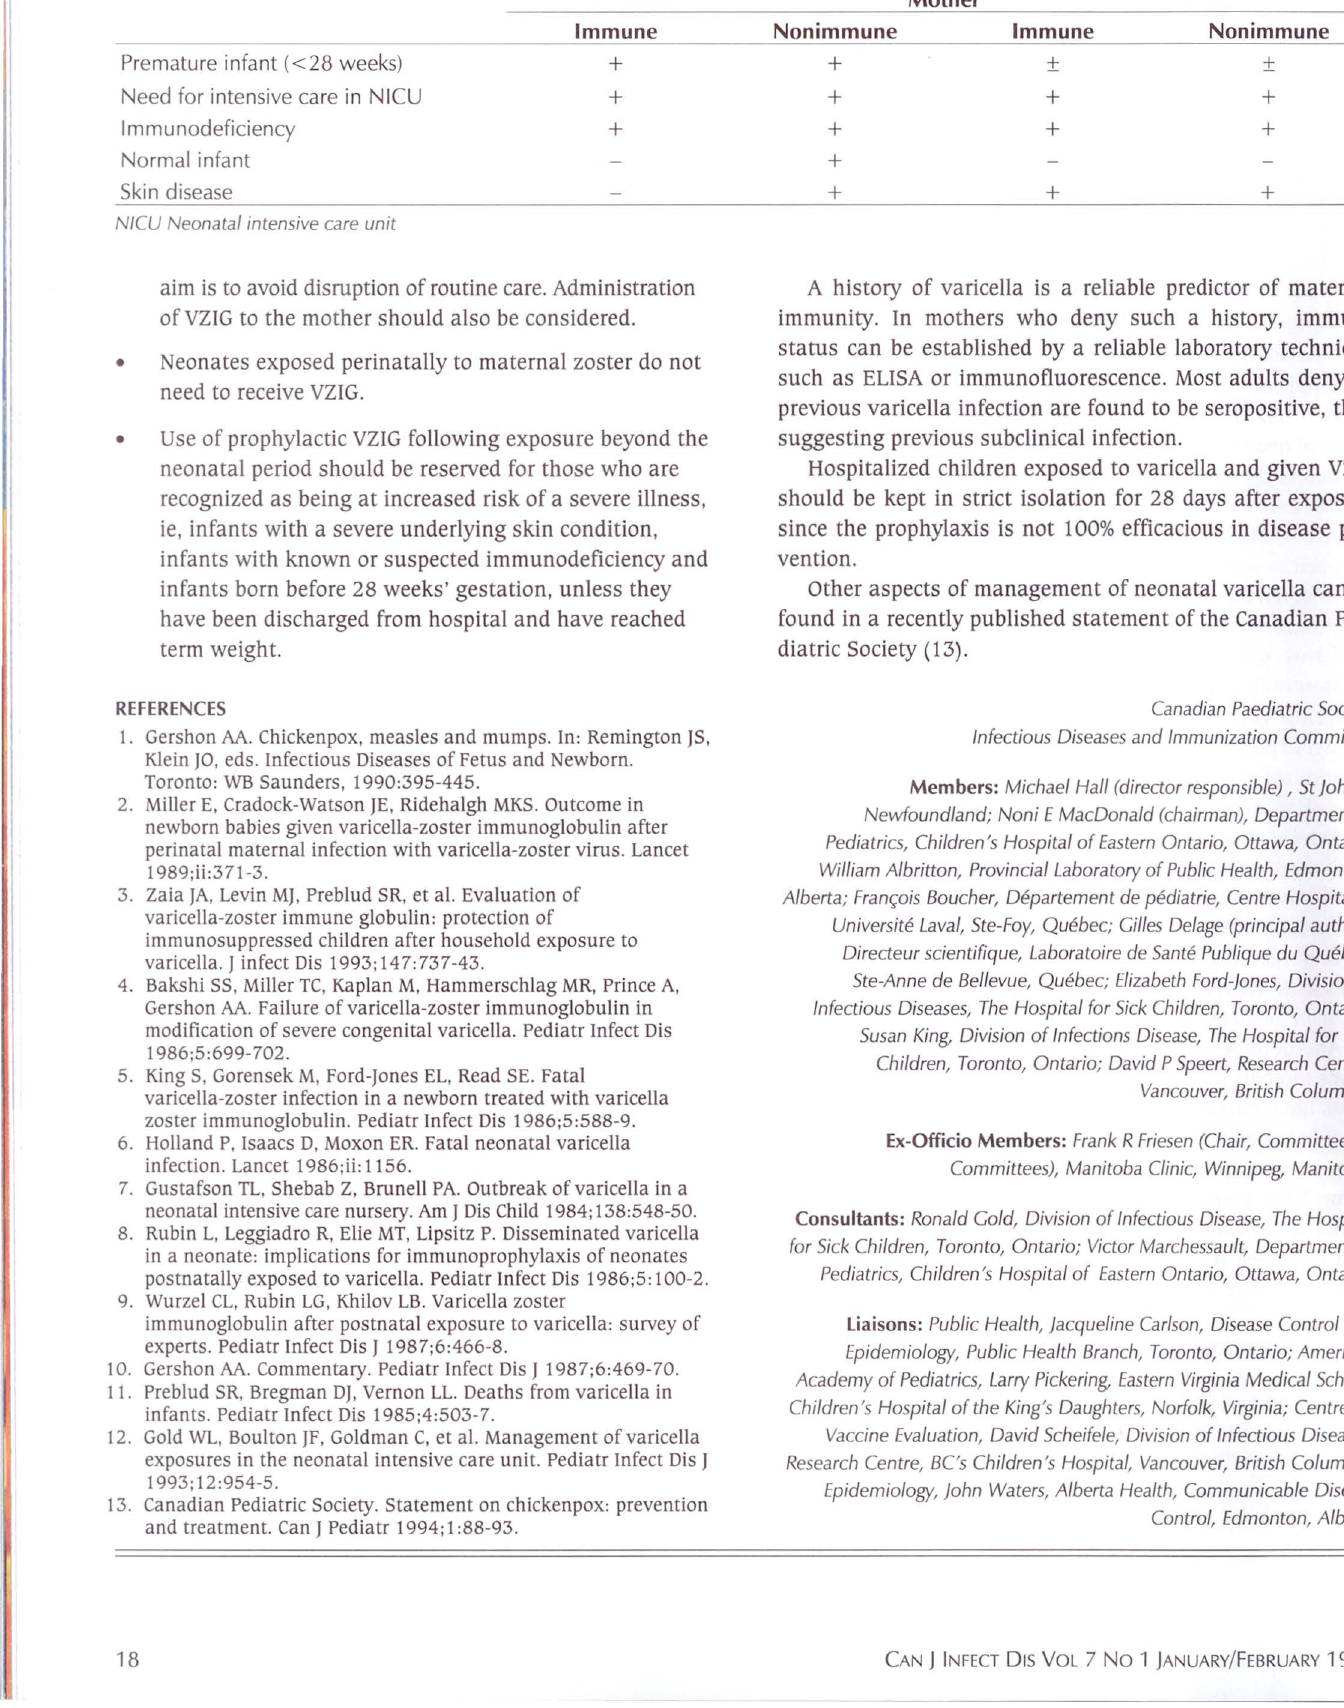
Indication for varicella zoster immune globulin Premature infant (<28 weeks) Need for intensive care in NICU Immunodeficiency Normal infant Skin disease NICU Neonatal intensive care unit aim is to avoid disruption of routine care. Administration of VZIG to the mother should also be